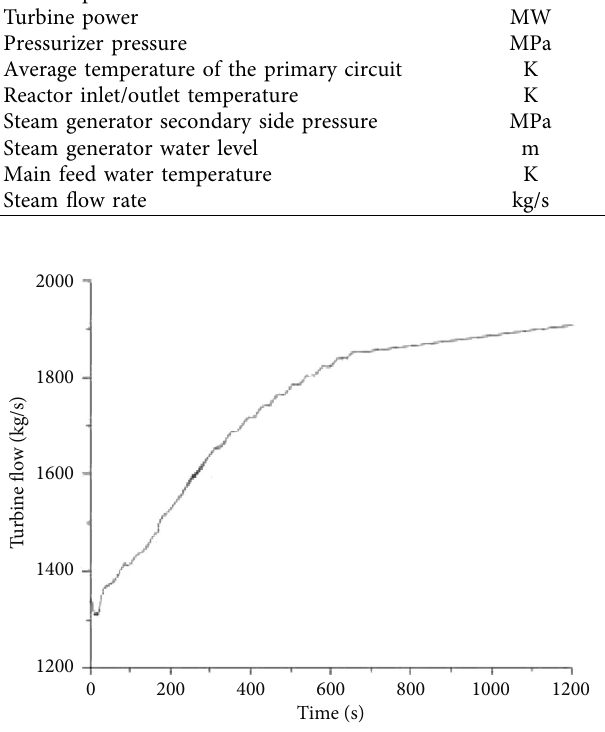
Figure 3: The changing trend of nuclear power at a linear increase in the